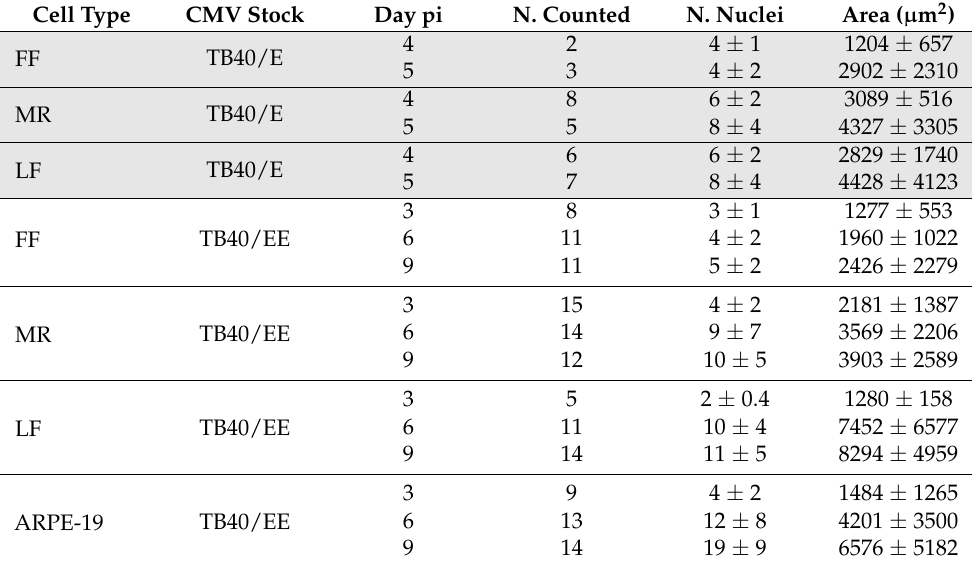
Table 1. Nuclei content and calculated area of syncytia present in monolayers of FF, MR, LF, or ARPE-19 cells infected with TB40/E (MOI of 0.5 pfu/cell) or TB40/EE (MOI of 0.1 pfu/cell). Mean and standard deviation values are reported. Cell Type CMV Stock Day pi N. Counted N. Nuclei Area ( µ m 2